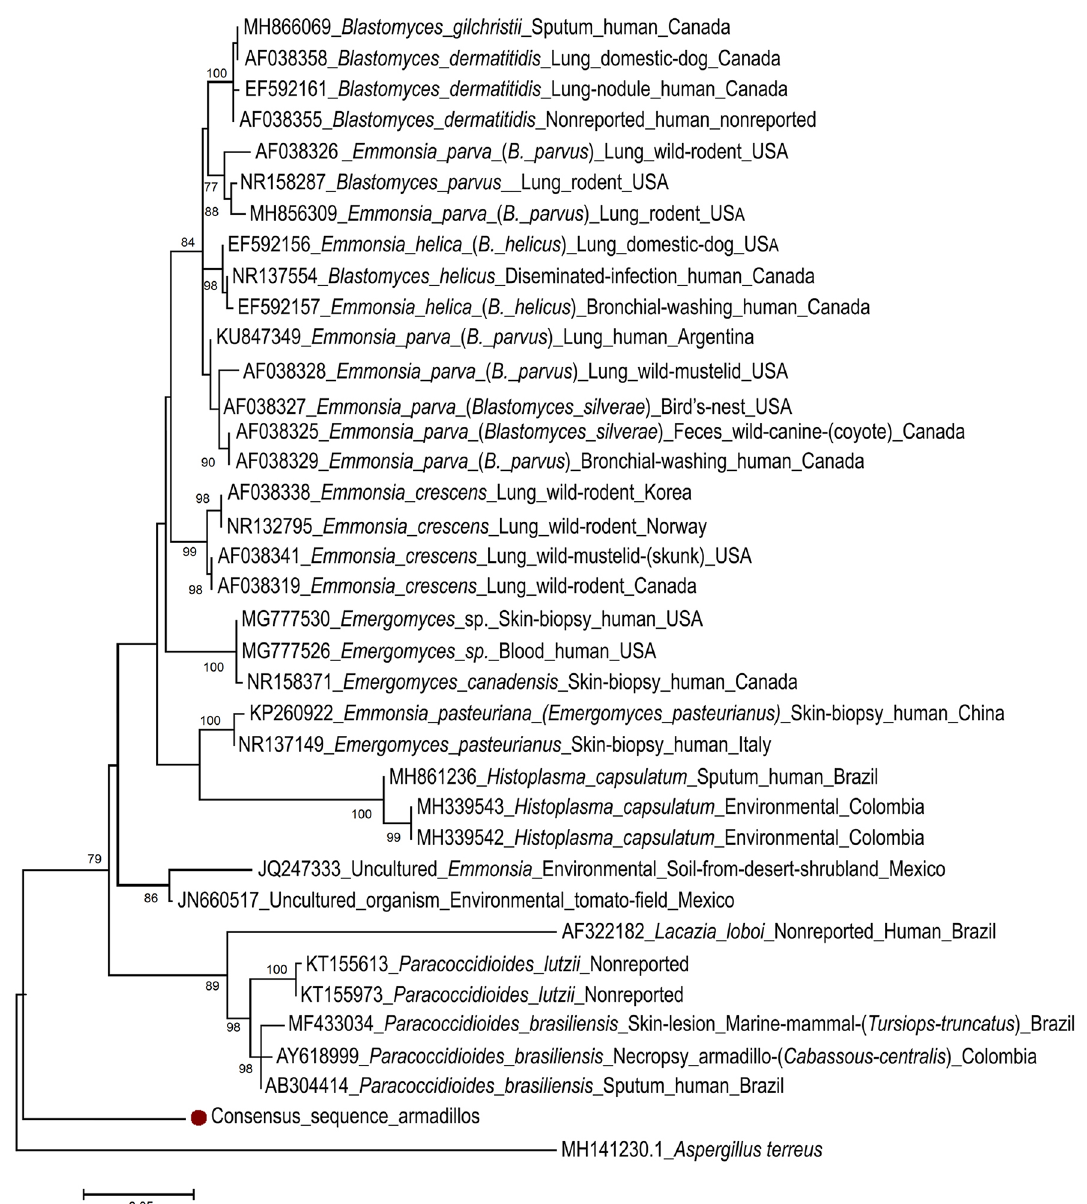
Figure 3. Maximum likelihood phylogram with 1000 bootstrap replicates of the alignment of the consensus internal transcriber spacer (ITS) 1, 5.8S rRNA gene and ITS 2 nucleotide sequence obtained in two six-banded armadillos ( Euphractus sexcinctus ) from this study, 35 selected fungi of the order Onygenales and Aspergillus terreus (MH141230) as